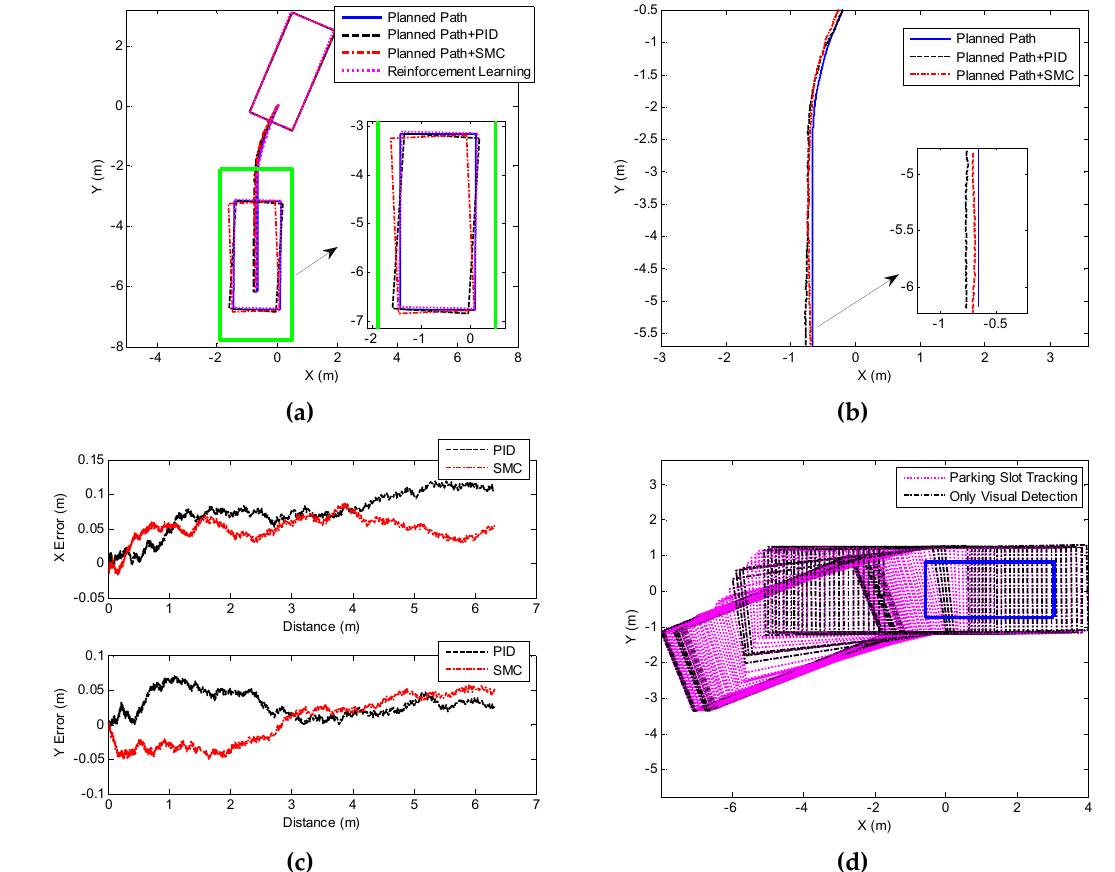
Figure 22. Experimental results of 30° perpendicular parking. ( a ) Parking performance of different methods; ( b ) and ( c ) present the control effect and error of different path tracking methods, respectively. ( d ) Parking slot detection and tracking in the parking process. Table 3. Experimental data of 30° perpendicular parking.